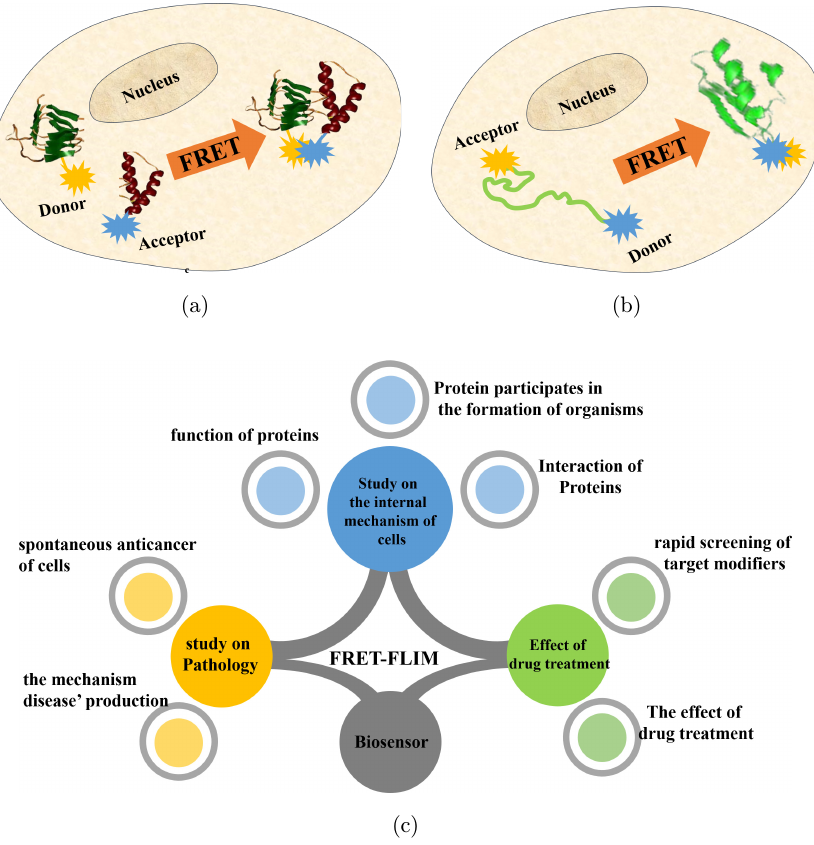
Fig. 3. Intracellular detection principle and application of FRET – FLIM technology. (a) Detect the interaction between proteins; (b) Detect the change of protein structure; and (c) Applications of FRET – FLIM technology. Table 1. Application of FRET – FLIM technique in the study of intracellular mechanisms. 29 – 34,40 – 45 FRET –